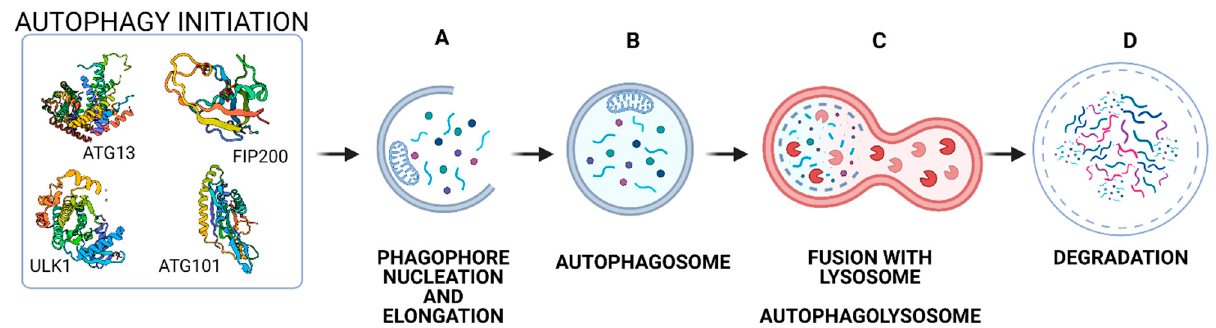
Figure 2. Various signals activate autophagy. The target of these signals is ULK 1 complex, which includes ULK1, FIP200, ATG13 and ATG101 protein. During autophagy fragment of cytoplasm is surrounded by C-shaped double-membrane ( A ), while autophagosome is being created as the result of connection of two membrane ends ( B ). Afterwards autophagosome fuses with lysosome. The resulting vesicle is known as an autophagolysosome ( C ). In this vesicle the degradation of macromolecular substrates for into their basic constituents occurs ( D ).